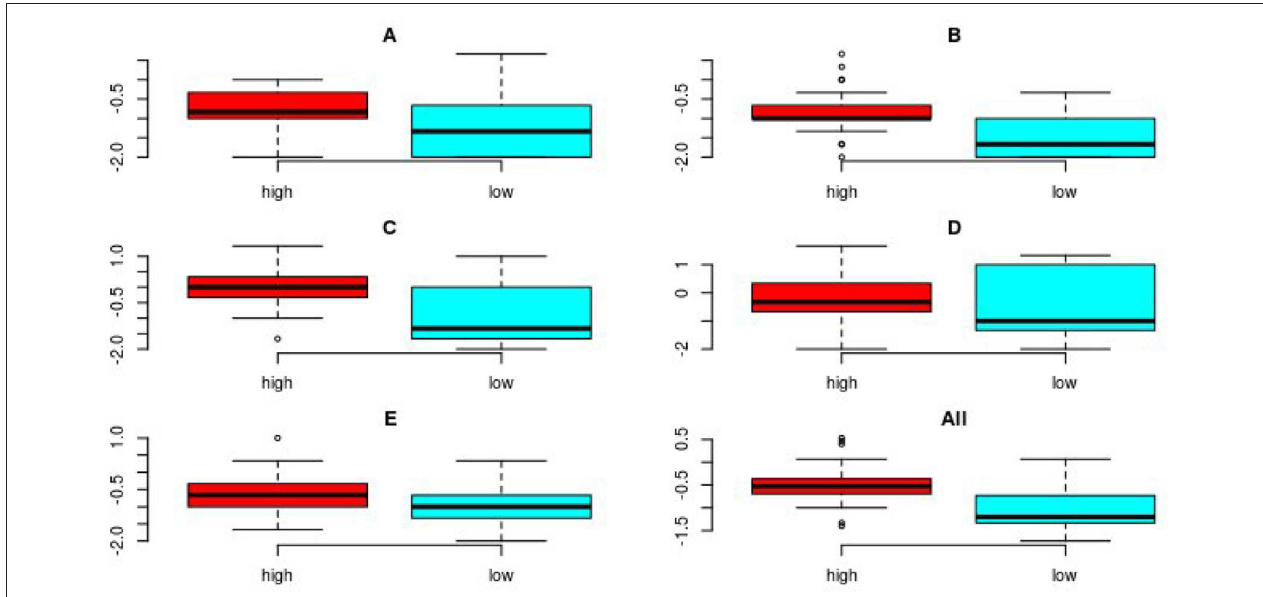
FIGURE 1 | Boxplots showing the combined results of the VGA for the three readers for all images for each of the 5 image criteria, (A–E) and for all criteria combined, for both image groups ( n = 44 and 45 for high quality/low quality, respectively). The boxes show the interquartile range of the data, the whiskers are set at 1.5 times the interquartile range or the maximum value and minimum values if these values are smaller or greater, respectively. The horizontal line shows the median of the data. Possible outliers are plotted individually outside the range of the whiskers. The median value for each image criterion evaluated and for all imaging criteria combined, was higher (indicating superior image quality) for the images in the high quality group compared to median value for images in the low quality